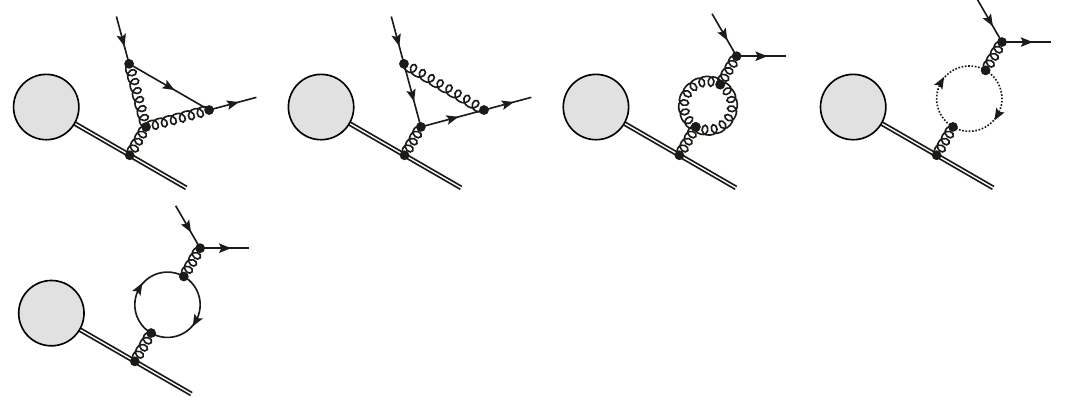
Figure 10 . Diagrams with only one gluon coupling to the Wilson line.